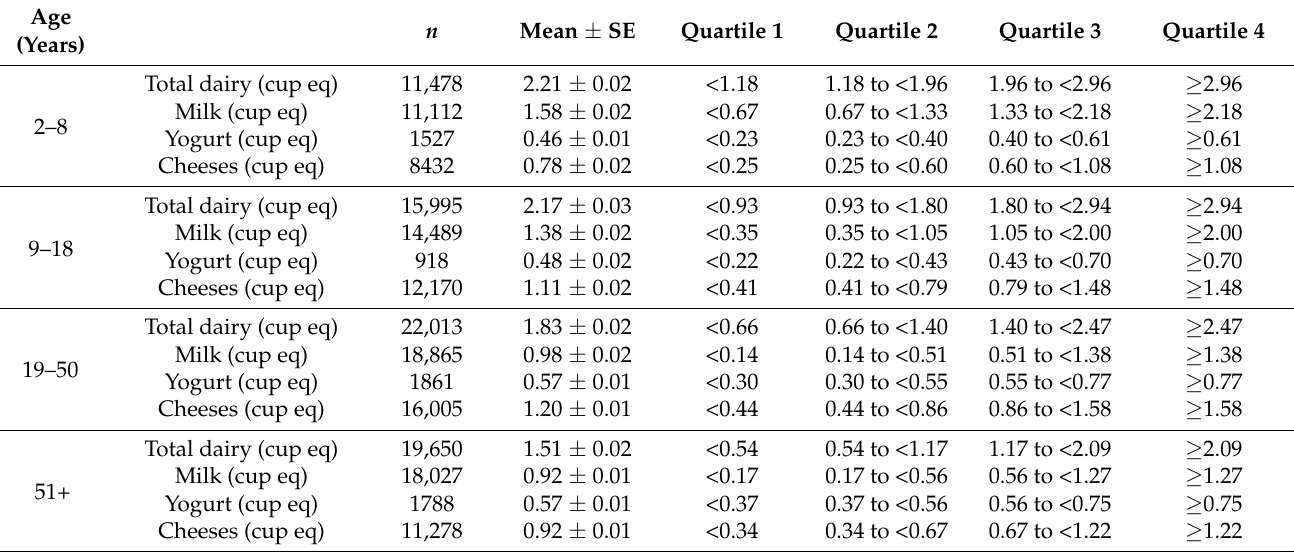
Table 1. Mean and quartiles of intake of dairy products among consumers of different age groups, gender-combined data NHANES 2001–2018.